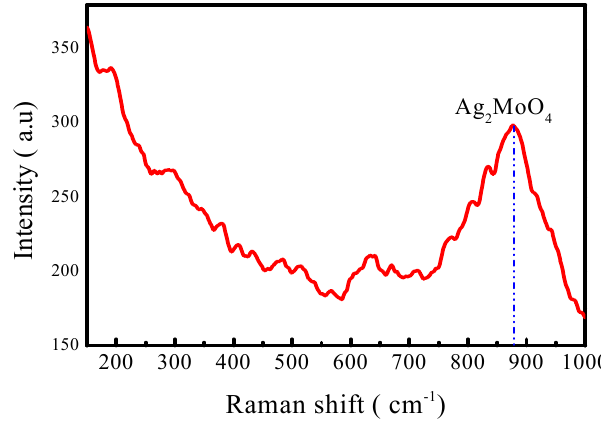
Figure 4. Raman spectra of AM before the wear test.